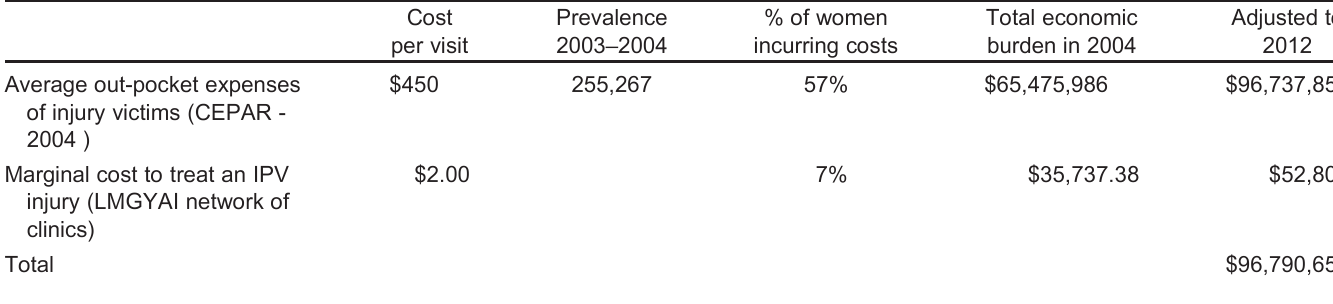
CEPAR, Center for the Study of Population and Responsible Parenthood ; IPV, intimate partner